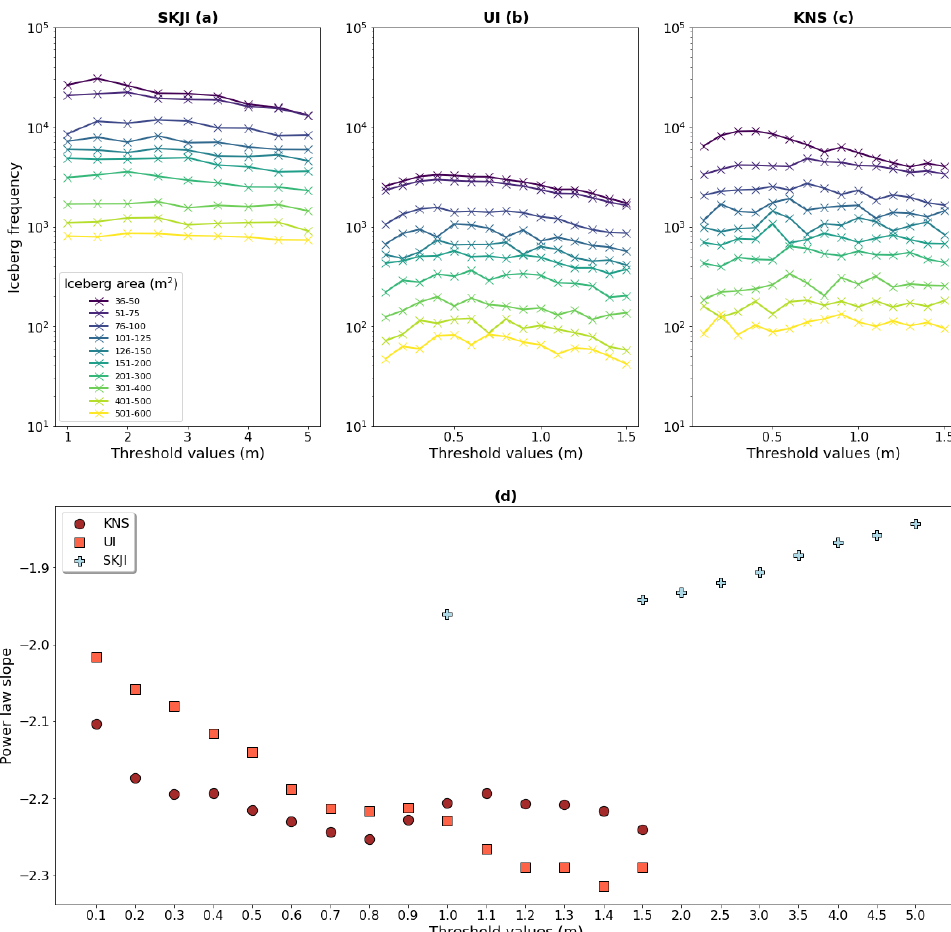
Figure 5. Iceberg frequency for each threshold value tested. (a) SKJI’s values were performed for 0.5m increments between 0 and 5m above sea level. Increments of 0.1m between 0 and 1.5m above sea level were run for both (b) UI and (c) KNS. Panel (d) shows how the α value for each glacier changes depending on which threshold value is chosen to detect its respective iceberg. Note the log scale on the y axis in the subplot: (a) – (c)